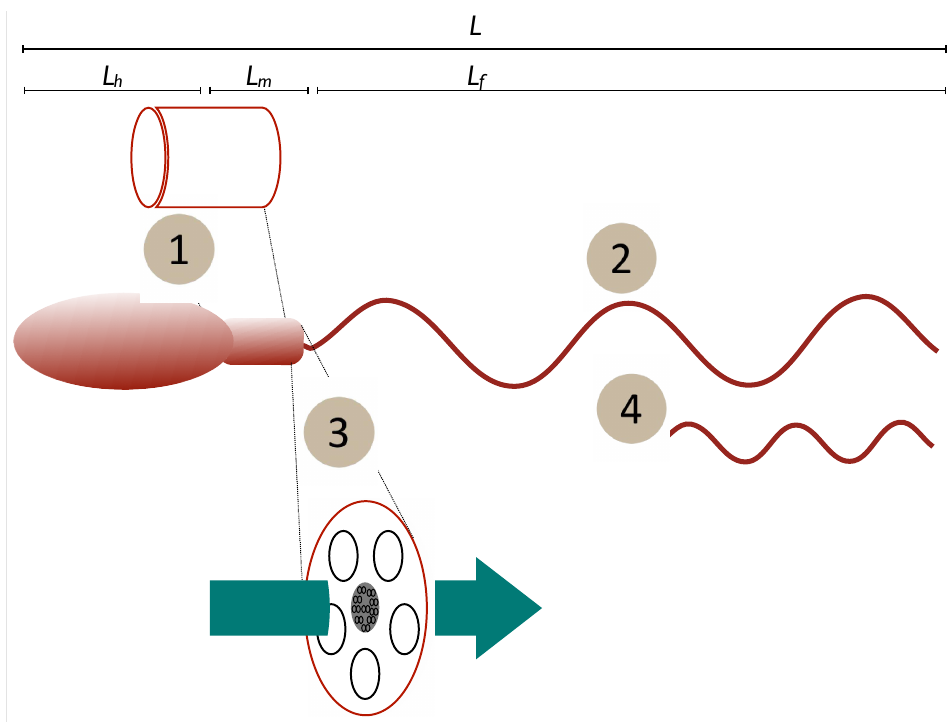
Figure 1. Schematic of potential relationships tween form and function. Mechanisms may be (1) mitochondrial/midpiece volume as a proxy for energy storage, (2) length of the power generator (flagellum), (3) midpiece or flagellum cross-section as a proxy for rate of diffusive transport of ATP and the creatine phosphate (CrP) shuttle or (4) power output that varies due to flagellar or dynein dynamics to maintain a constant force. Length measures: L —total cell length; L h —head length, L m , midpiece length, L f —flagellum